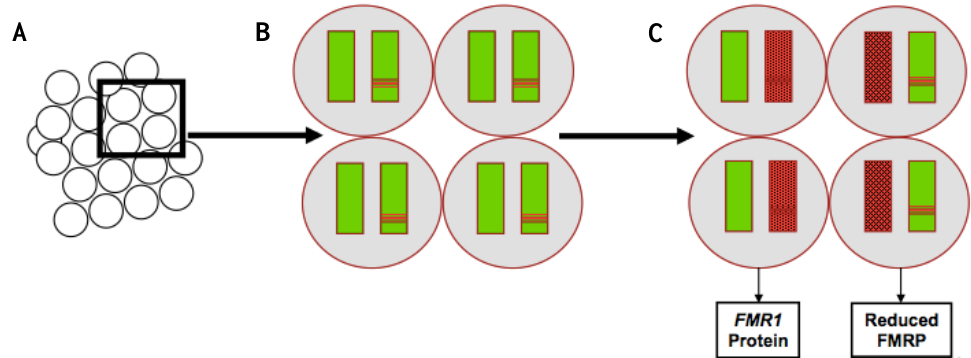
Figure 1. X-chromosome inactivation in females with fragile X syndrome and corresponding production of fragile X mental retardation 1 ( FMR1) protein in each cell. ( A ) Group of progenitor cells. ( B ) Each cell contains two X chromosomes. The unaffected chromosomes are shown in solid green, and affected chromosomes are depicted with a red band. ( C ) One of the two chromosomes in each cell will be silenced at random indicated with red shading. In cells where the affected chromosome is silenced, there is normal production of the FMR1 protein. In cells where the unaffected chromosome is silenced, there is reduced production of the FMR1 protein. FMR1 : fragile X mental retardation 1; FMRP: fragile X mental retardation protein.